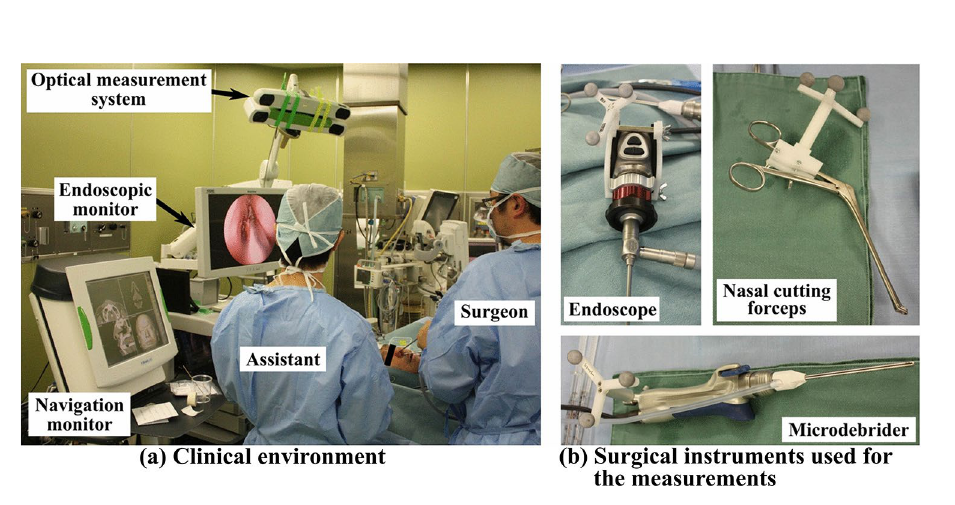
Figure 1. The setup for clinical study 7